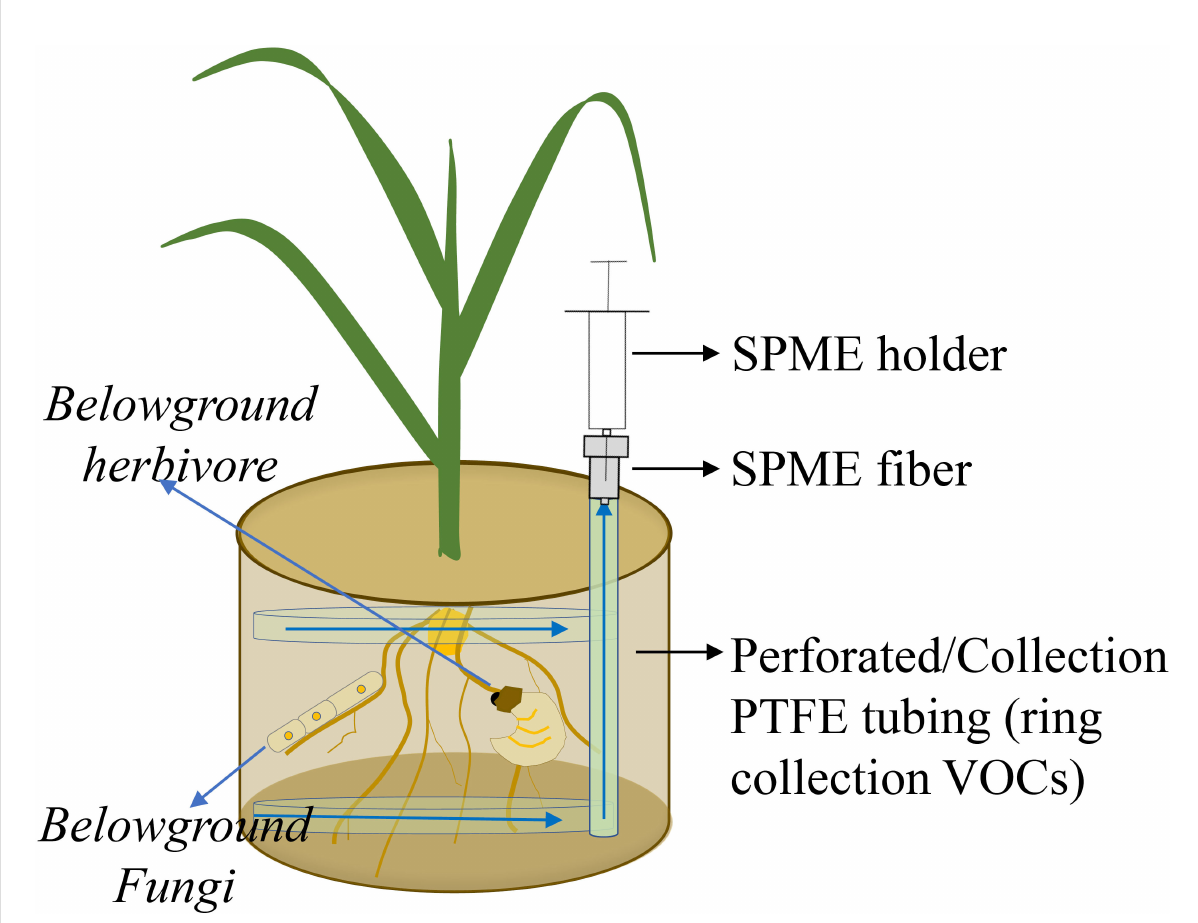
FIGURE 3 Volatile organic compound (VOC) emissions from roots, soilborne organisms, and soil matrix are collected by a passive system. VOCs are trapped by a solid phase micro extraction (SPME) fi ber. Polytetra fl uoroethylene